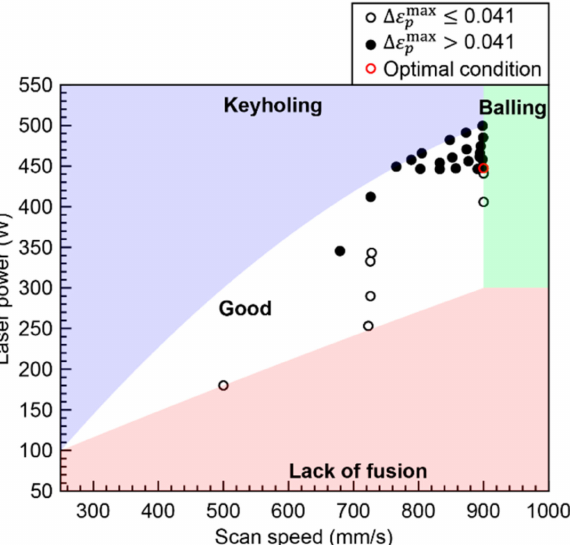
Figure 12. Results of optimal laser irradiation condition search by Bayesian optimization. (Optimal laser power: 447 W, Optimal scan speed: 900